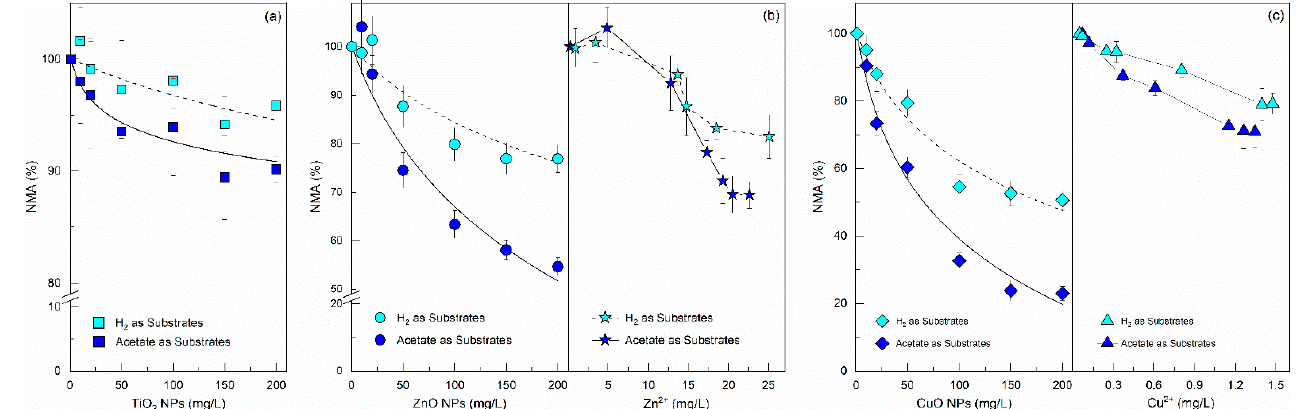
Figure 1. NMA determined in batch toxicity assays as a function of the initial concentration of TiO 2 NPs ( a ), ZnO NPs ( b ), or CuO NPs ( c ) using acetate or hydrogen as substrates; NMA is presented as a function of the final concentration of their corresponding dissolved Zn 2+ or Cu 2+ , which was calculated from Equation (1). Error bars represent standard deviations of triplicate tests.